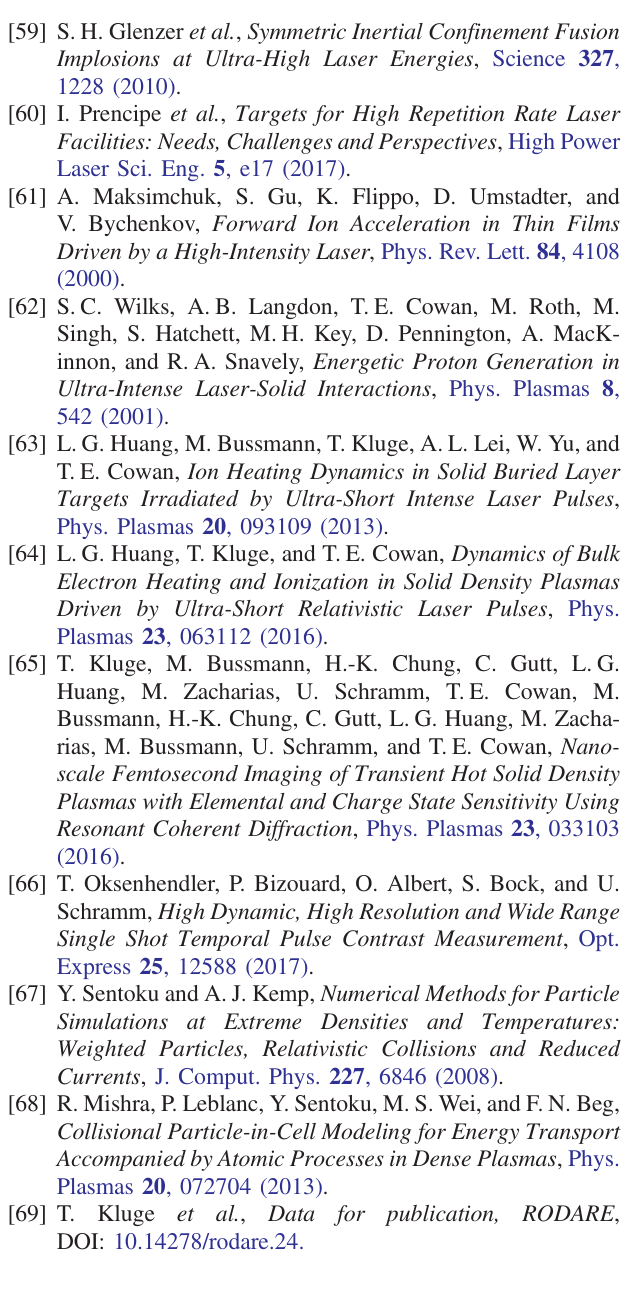
Fig. 4 and movie of the temporal evolution of the simulated electron